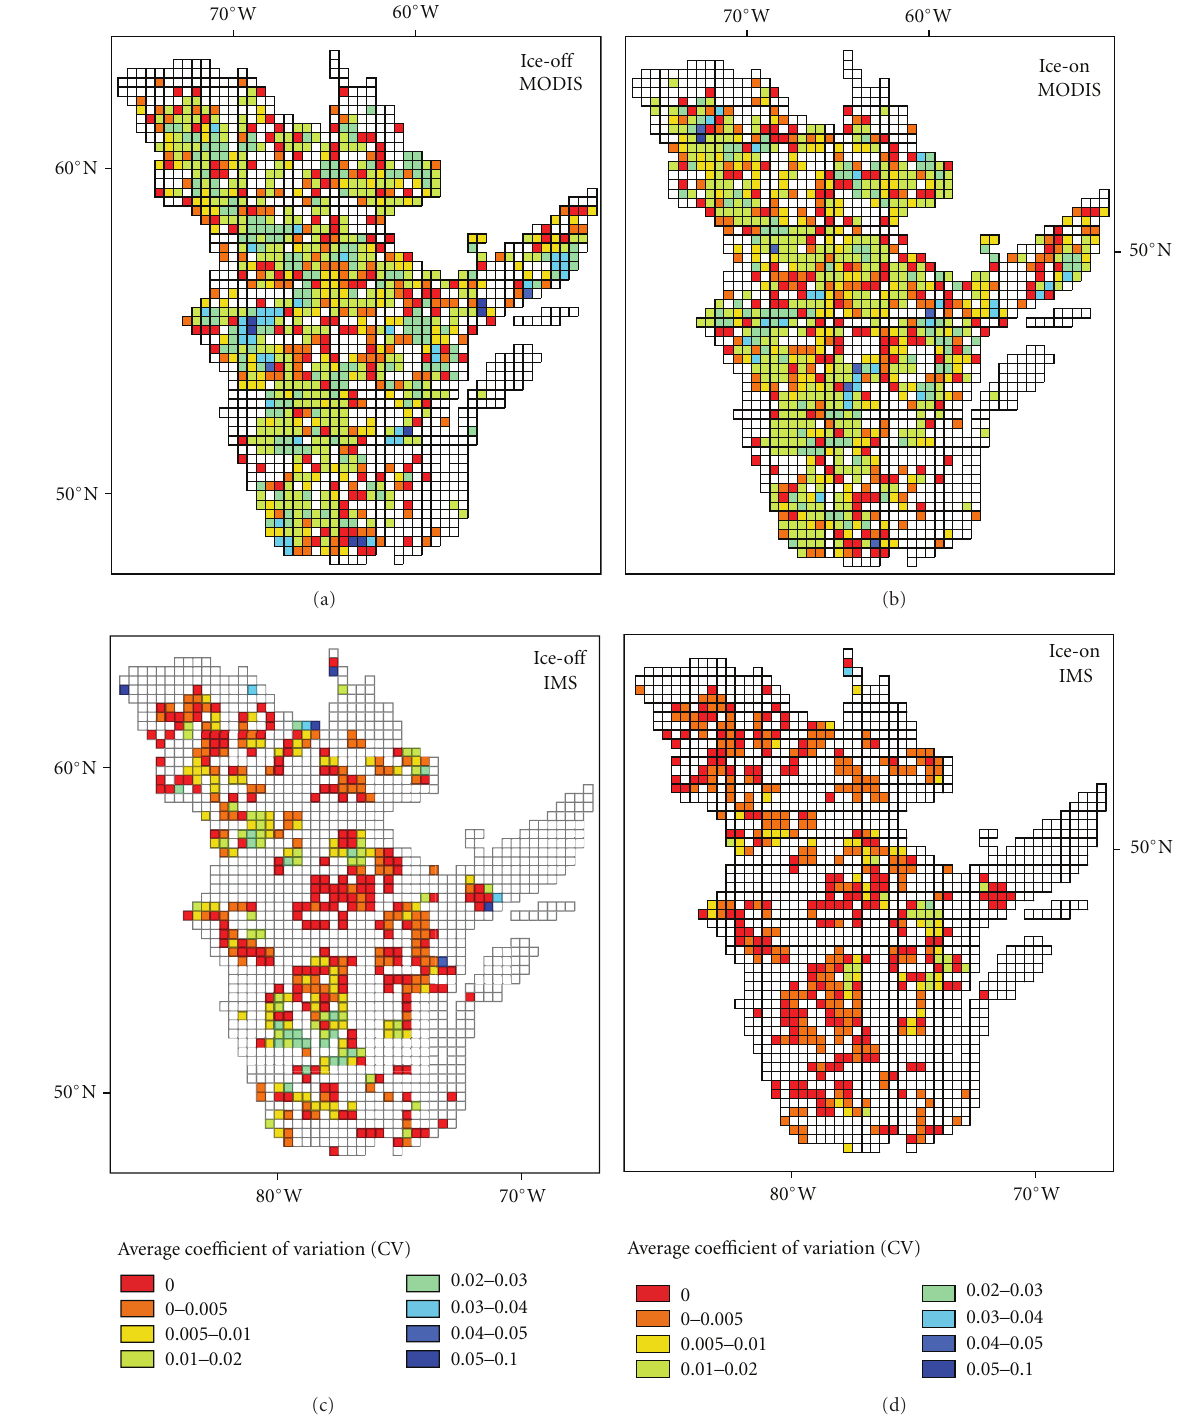
Figure 6: Average coe ffi cient of variation (CV) for each grid cell for ice-on and ice-o ff for MODIS: 2000–2010 (top) and IMS: 2004–2010